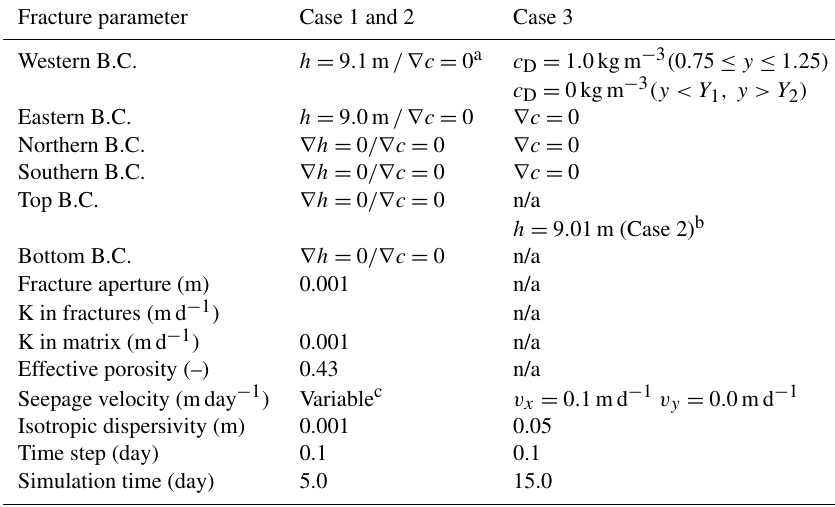
Table 1. The flow and transport parameters that were used for the transport verification cases. Fracture parameter